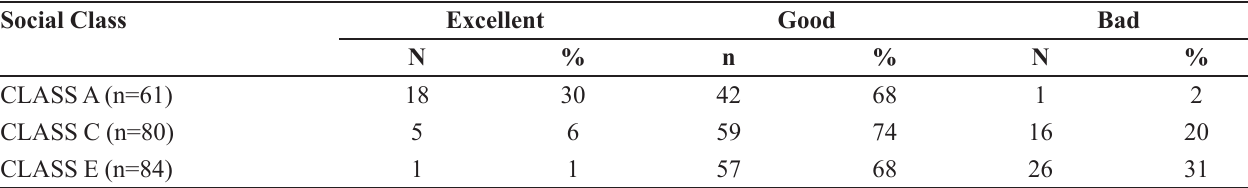
TABLE III – Self-reported health status of elderly population interviewed. Porto Alegre/Rio Grande do Sul State, 2007 Social Class